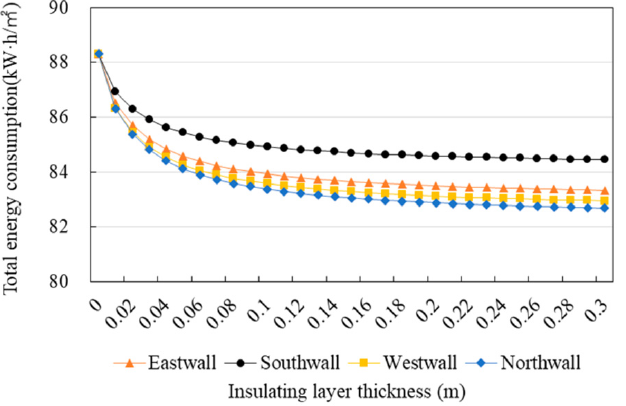
Figure 9. Relationships between insulation layer thickness and total energy consumption for four